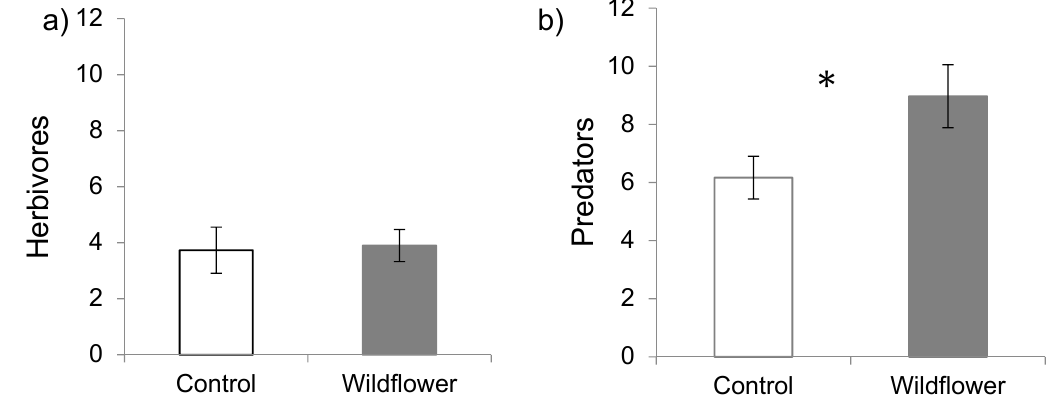
Figure 2. Mean ( ± SE) abundance of ( a ) herbivores and ( b ) predators sampled from pitfall traps in strawberry plantings with and without a wildflower border.